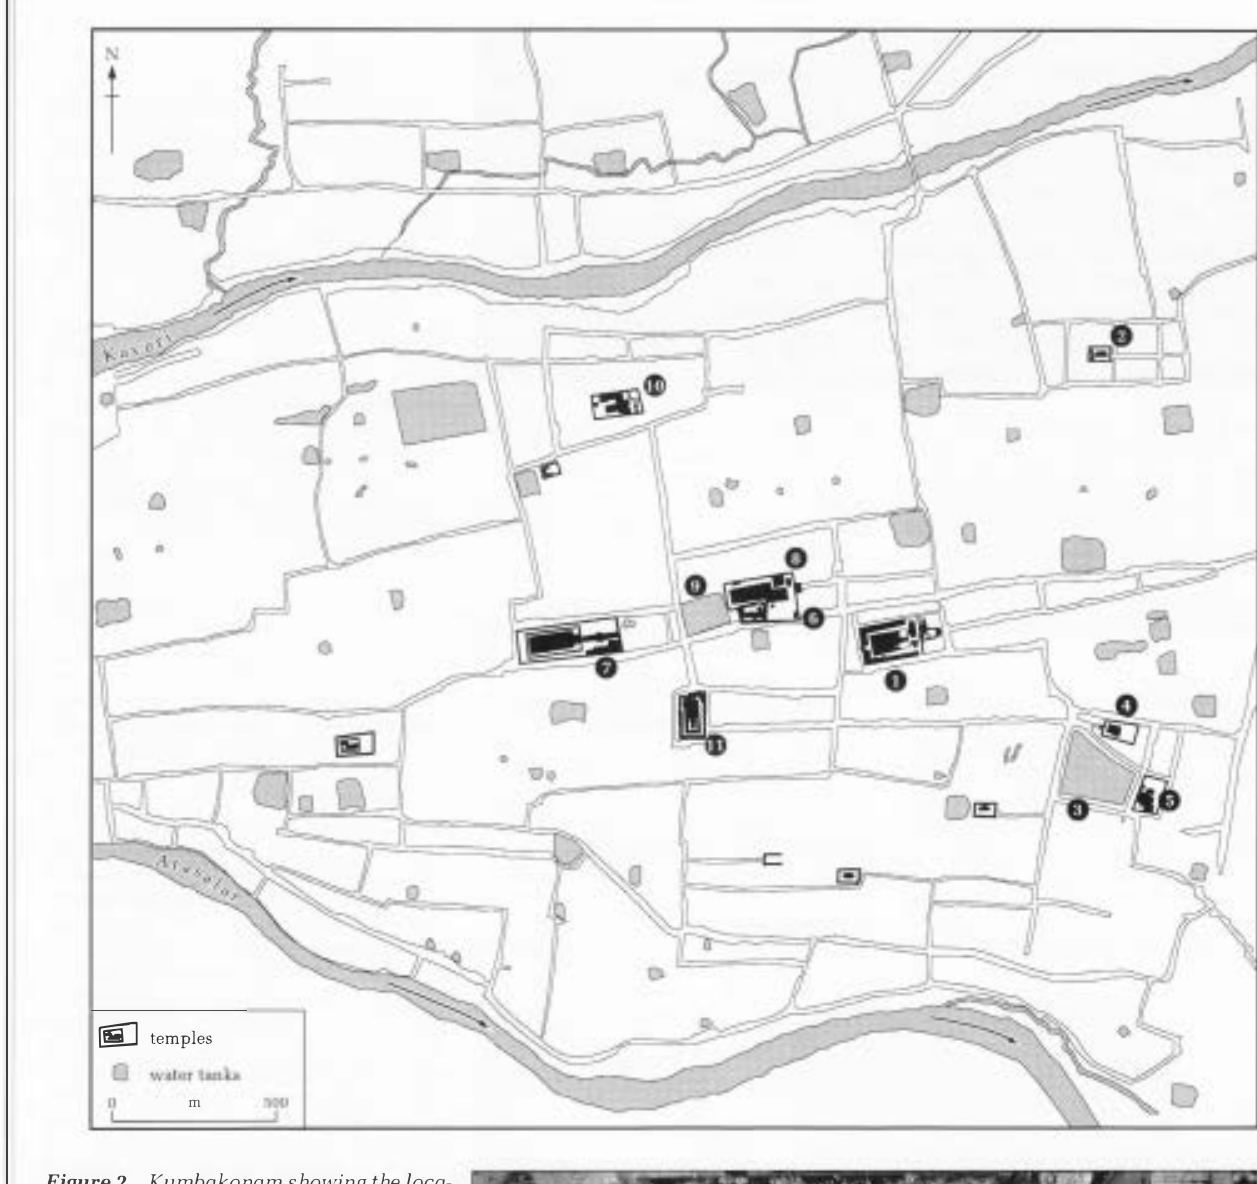
Figure 2 Kumbakonam showing the